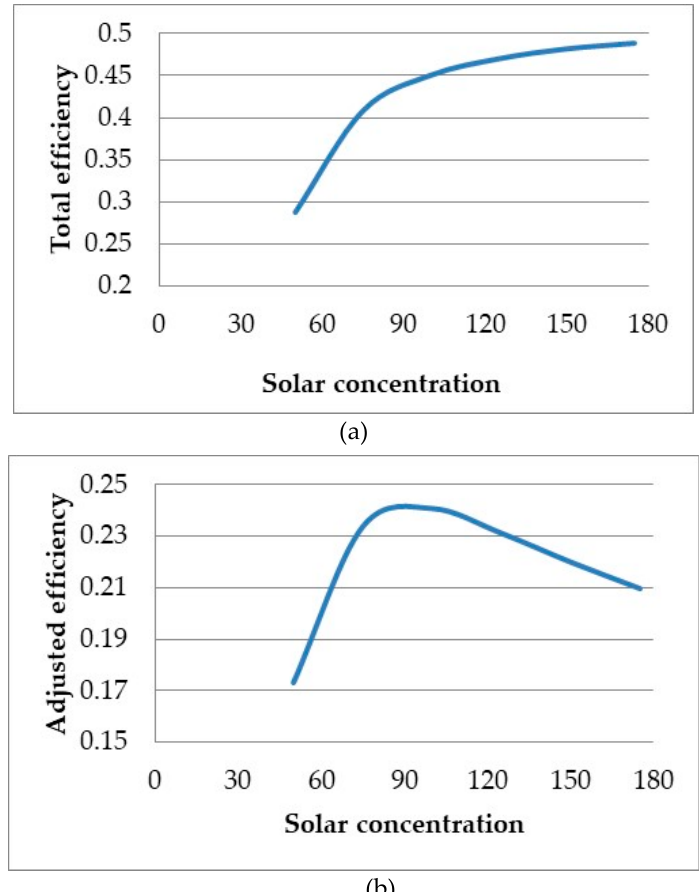
Figure 21. Solar concentration comparison for volume fraction of 0.0005 at a peak temperature of 873 K: ( a ) the total efficiency and ( b ) the adjusted efficiency.